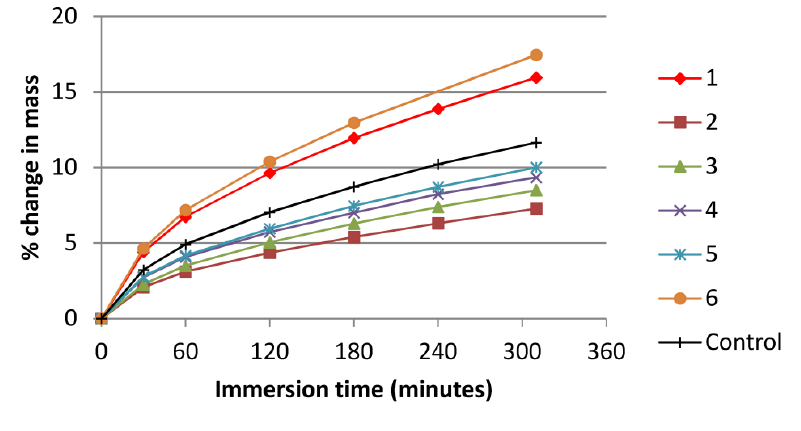
Figure 6. Percentage change in squeegee mass during immersion in ethylene glycol diacetate used in silver (print)